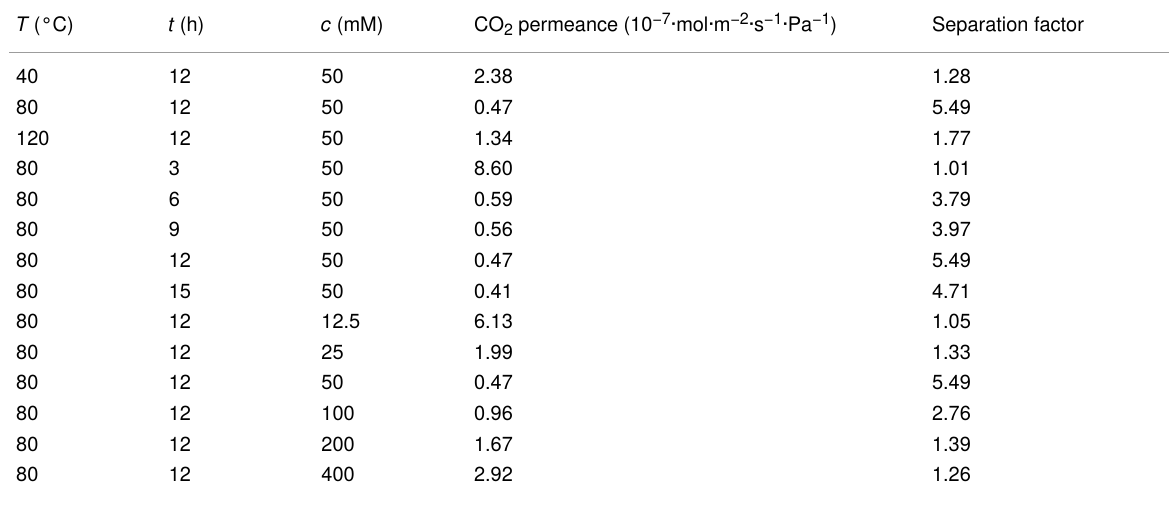
Table 2: Summary of gas (CO 2 /N 2 ) separation performance of ZIF-8 membranes from interfacial synthesis ( T represents reaction temperature; t represents reaction time; c represents the concentration of the 2-methylimidazole/1-octanol solution). T (°C)